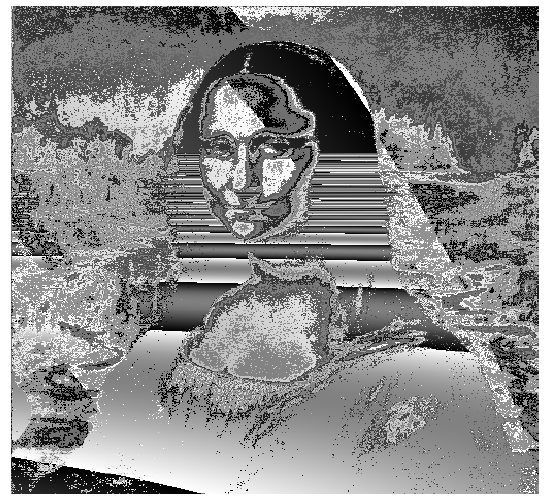
Figure 13. Speedup for PCNN Echocardiogram Processing